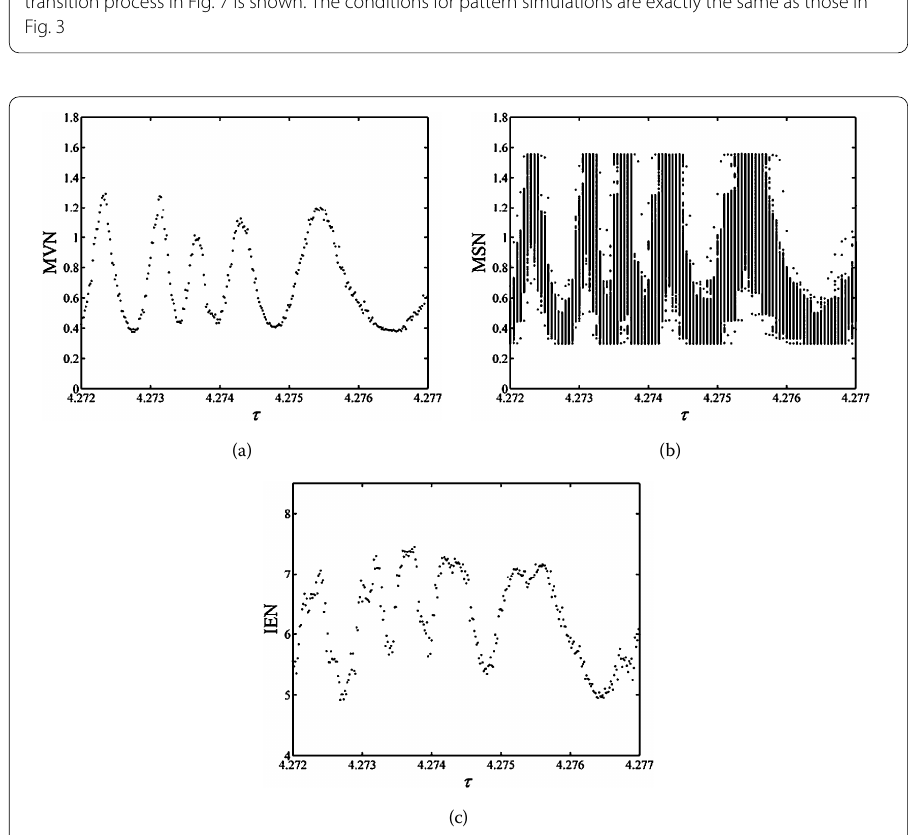
Figure 9 Graphs of ( a ) MVN, ( b ) MSN, and ( c ) IEN corresponding to Fig. 7. The waved variations of MVN, MSN, and IEN explicitly display the cyclic pattern transition process in Fig.